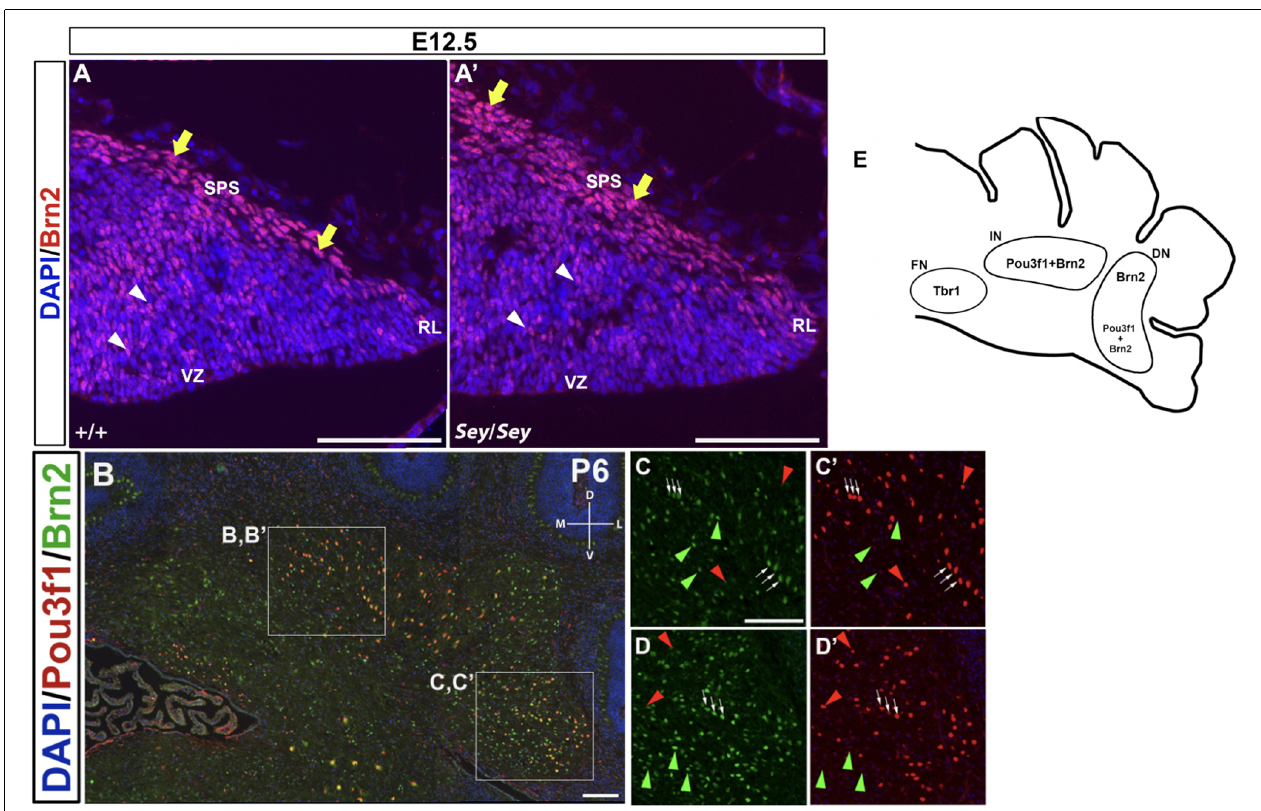
FIGURE 7 | The expression pattern of Brn2 at early (E12.5) and late (P6) timepoints and its relationship to Pou3f1. (A) In the E12.5 wild-type cerebellum, Brn2-expressing cells are present along the subpial stream (SPS) (yellow arrows) and in the cerebellar parenchyma (white arrowheads). (A’) In the E12.5 Sey mutant cerebellum, Brn2 expression recapitulates that in the wild-type counterpart. (B) Co-expression of Pou3f1 and Brn2 is evident in both the interposed ( C,C’ , white arrows) and the dentate nuclei ( D,D’ , white arrows). Approximately 70% of Pou3f1 + CN neurons also express Brn2. Red arrowheads indicate cells that are Pou3f1 + but Brn2 − , while green arrowheads indicate cells that are Brn2 + but Pou3f1 − . (E) A schematic diagram showing the nuclear distributions of Pou3f1 + , Tbr1 + , and Brn2 + populations in the P6 cerebellar coronal section. Panels (A,A’) show sagittal sections, while (B–D’) show coronal sections. DN, dentate nucleus; D, dorsal; FN, fastigial nucleus; IN, interposed nucleus; L, lateral. M, medial; RL, rhombic lip, SPS, subpial stream, V, ventral; VZ, ventricular zone. Scale bars, 100 µ